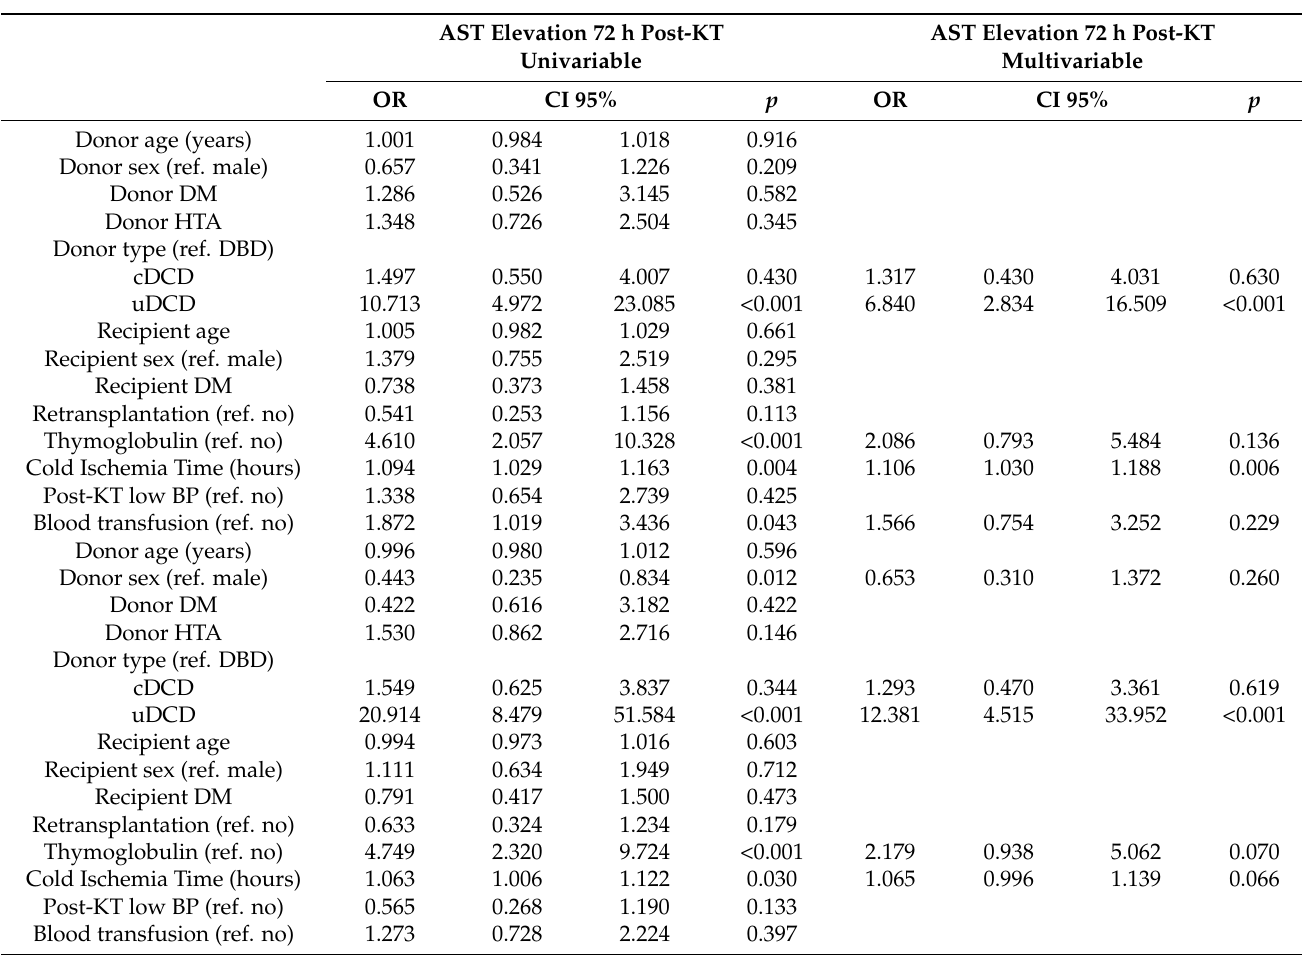
Table 3. Univariable and Multivariable analysis showing factors associated with early hypertransaminasemia after trans- plantation. Analyses were made with binary logistic